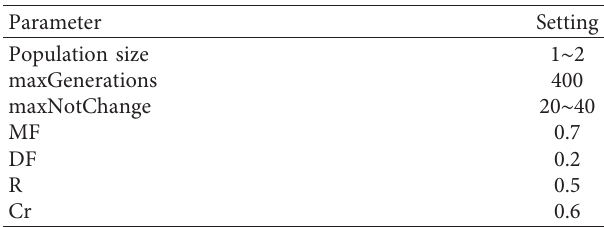
Table 3: Parameter settings. Parameter